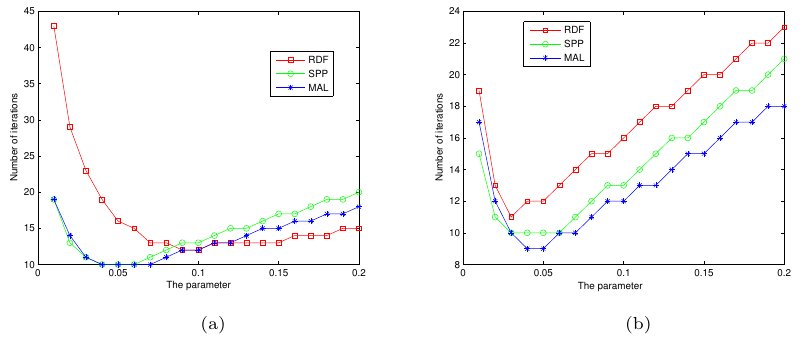
Figure 3. The sensitivity of the parameters in the RDF, SPP, and MAL preconditioners for steady Oseen problem (Q2-Q1, uniform grids, ν = 0 . 01). (a): 32 × 32, (b): 64 ×